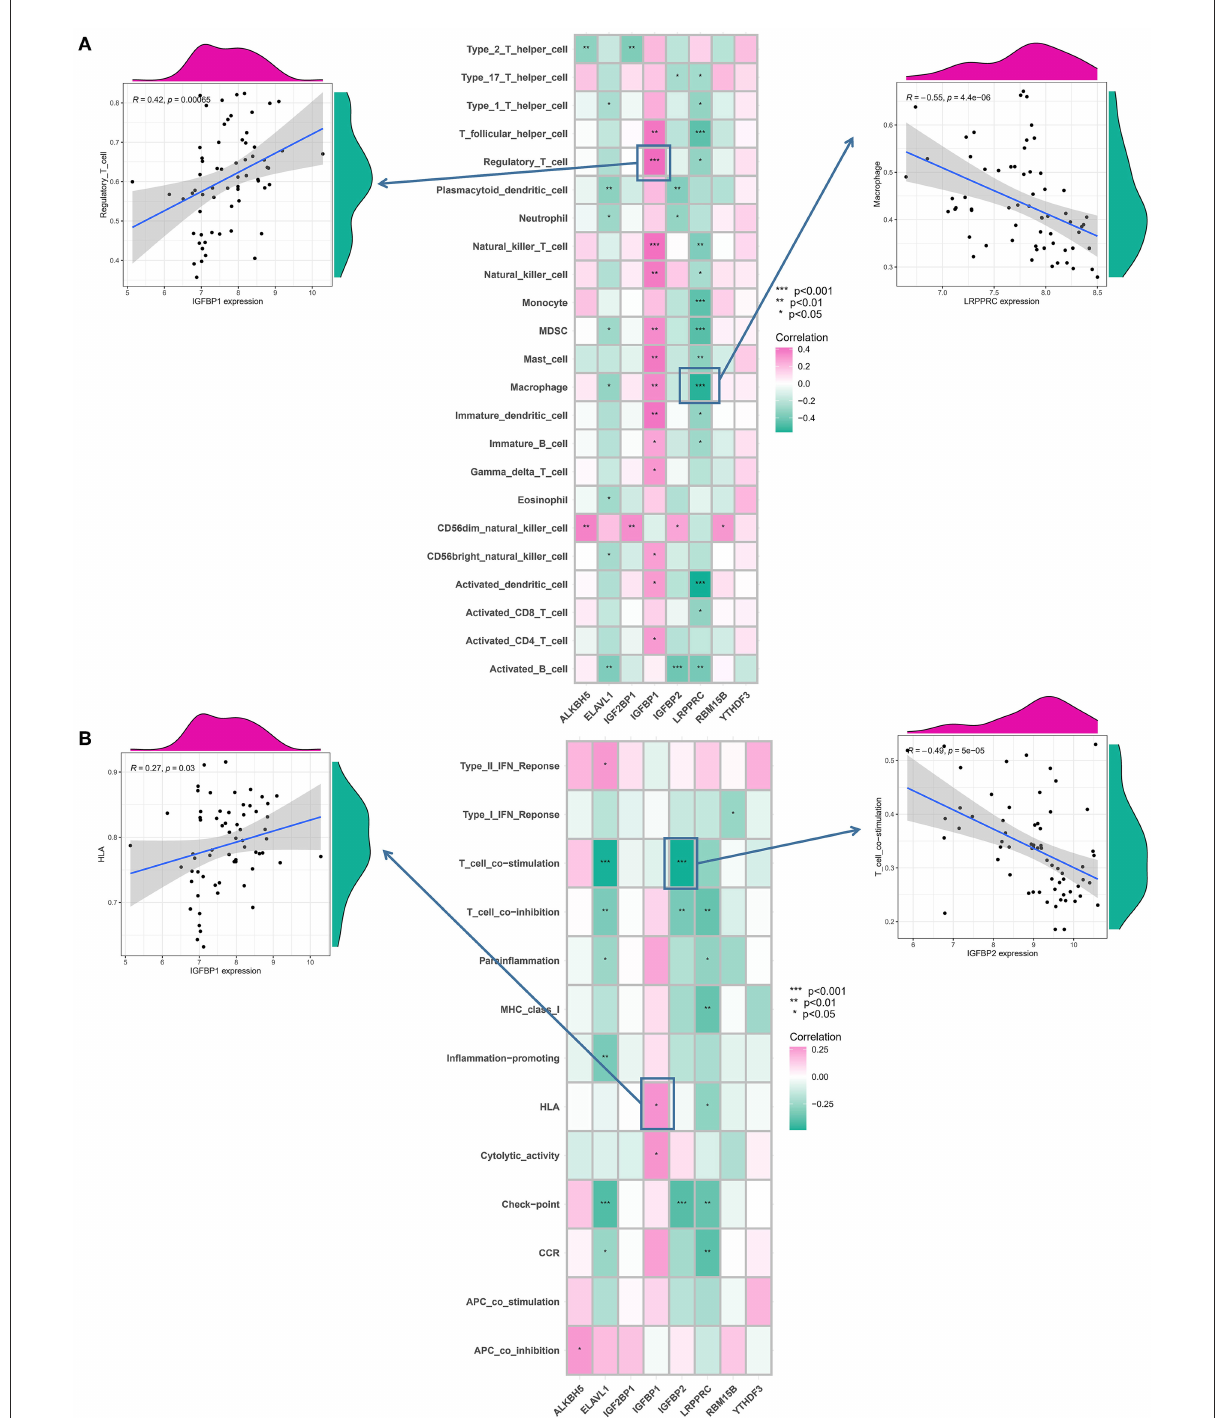
FIGURE5 Correlation between immunocytes infiltration, immunological response gene-sets, and m6A modulators. (A) Correlation between each dysregulated m6A modulator and dysregulated immunological microenvironment infiltration cell type is illustrated by the square plot. The IGFBP1-regulatory T-cell pair has the highest positive correlation between immunocyte and m6A modulator. LRPPRC–macrophage pair has the most negative correlation between immunocyte and m6A modulator. (B) Correlation between each dysregulated m6A modulator and dysregulated immunological response gene set using a square plot. Intracranial aneurysms (IAs) had the highest positive correlation between IGFBP1 and HLA, suggesting elevated expression level of IGFBP1 and highly active HLA in IA. IGFBP2–T cell co-stimulation pair has the strongest negative correlation. The symbols * , ** , and *** indicates the value of p < 0.05, p < 0.01, and p < 0.001